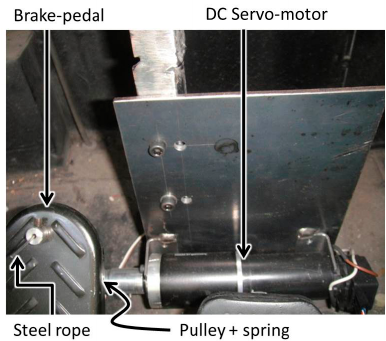
Figure 3. Actuator implementation for the brakes.